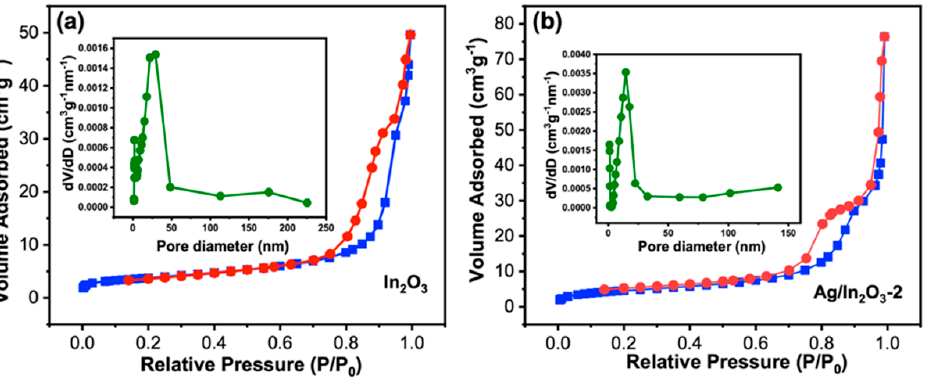
Figure 4. N 2 adsorption and desorption isotherms and pore-size distribution curves (insets) of ( a ) In 2 O 3 and ( b ) Ag/In 2 O 3 -2.